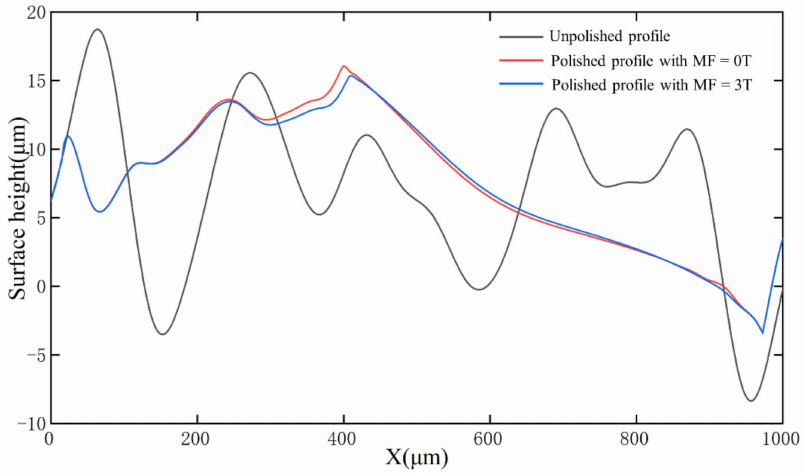
Figure 17. Morphology of the top of the molten pool at t = 20 ms.